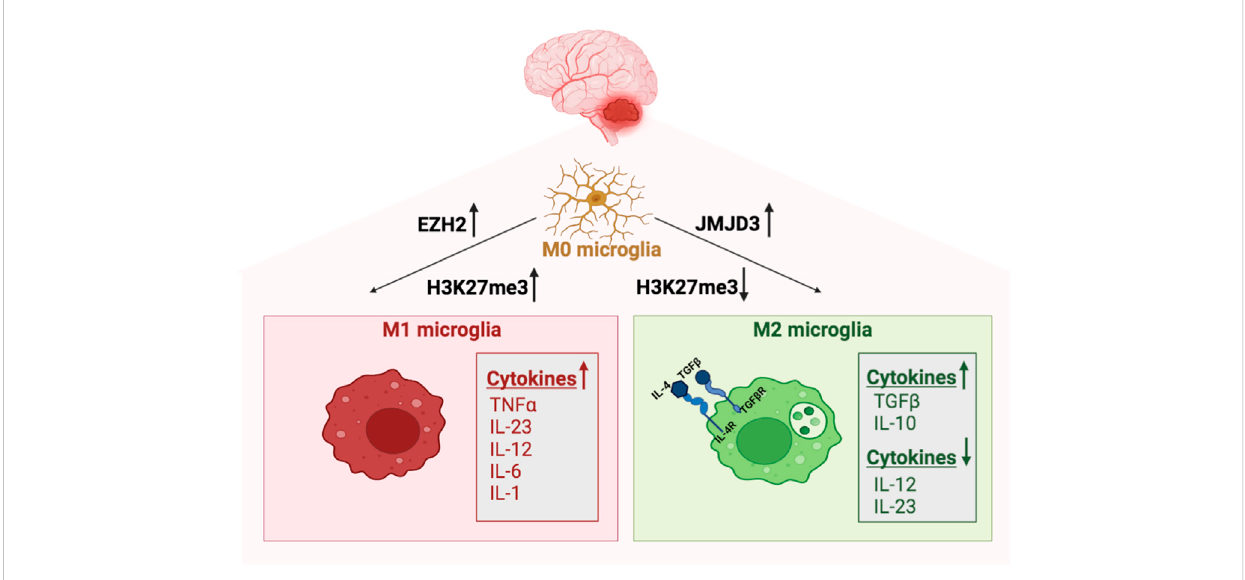
FIGURE 1 Epigenetic regulation of microglia in MB. Microglia polarize into M1 phenotype following the H3K27 histone tri-methyltransferase activity of EZH2. The M1 classical microglia secretes proin fl ammatory cytokines, with a most prominent action of interleukins IL-23, IL-12, IL-6, IL-1 b and tumor necrosis factor-alpha (TNF- α ). In contrast, the demethylase activity of JMJD3 promotes M2 microglia, which is associated with low expression of MHC-II, IL-12, and IL-23 and production of anti-in fl ammatory cytokines acting like TGF- b and